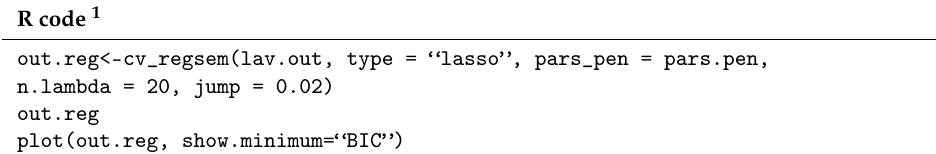
Table 4. R code for lasso regularization and corresponding